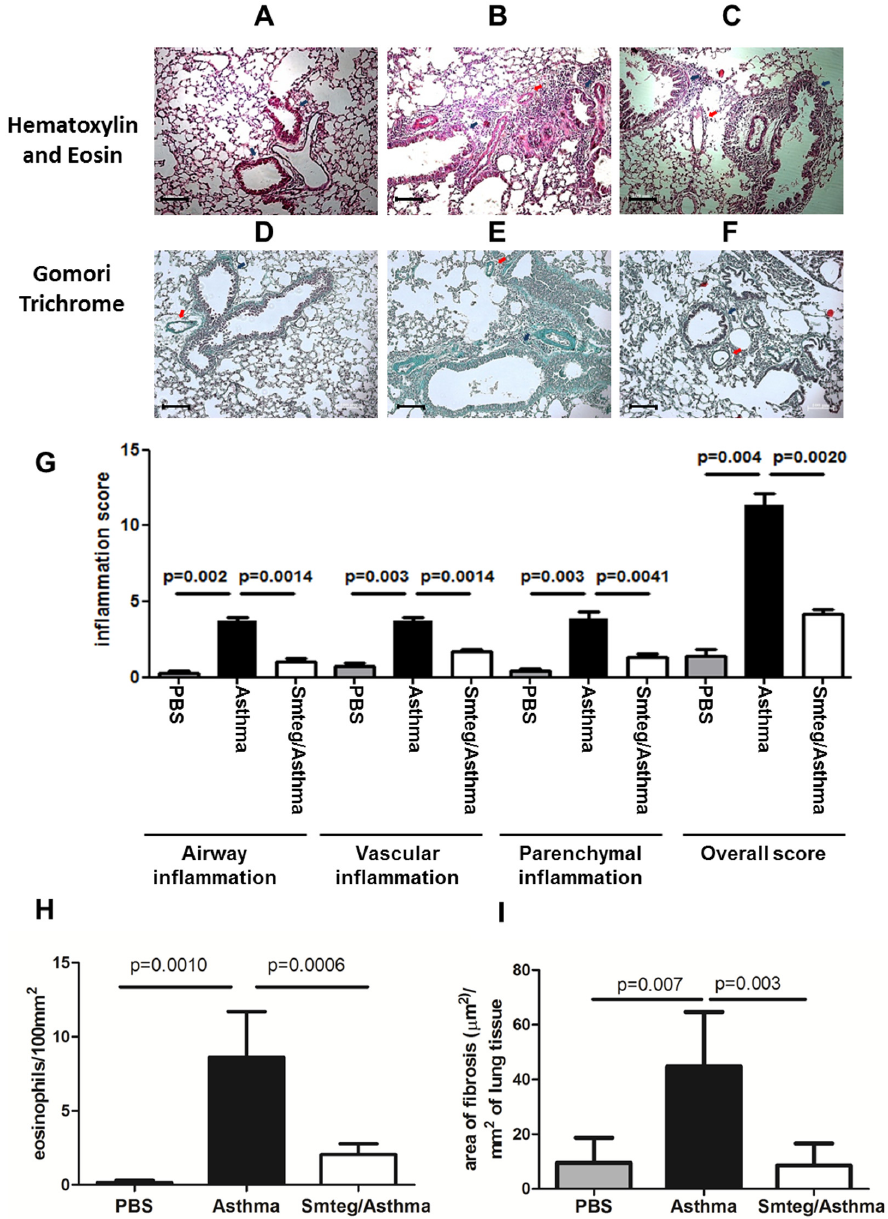
Fig 4. Lungs histopathology analysis. Upper panel shows lungs stained with HE and bottom panel shows lungs stained with Gomori Trichrome. Lungs from PBS control group ( A and D ) presented almost no infiltrate and collagen deposition. Asthmatic mice ( B and E ) presented intense inflammatory infiltrate and collagen deposit. Animals treated with Smteg ( C and F ) showed reduced levels of these parameters. Blue arrows point to peribronchiolar area and red arrows point to perivascullar area. Magnification 10x; bars 100 μ m. Semiquantitative analysis of inflammation ( G ) was performed in lung sections from five animals per group in magnification of 20x. Increased inflammation was observed in Asthma group compared to PBS and Smteg treated mice. Eosinophil number was determined in lung section ( H ) from five animals per group at a magnification of 63x. Results were expressed as the mean number of eosinophil/100mm 2 +/- SD. Smteg treatment significantly decreased the number of eosinophils in the lung. Collagen deposition was measured by morphometric analysis of lung sections stained with Gomori Trichrome (I) at a magnification of 10x. Results are expressed as area of fibrosis ( μ m 2 )/mm 2 of lung tissue. Significant reduction in collagen deposition was observed in Smteg treated group. Significant differences between groups are pointed in the Graphics. Data are representative of 2 independent